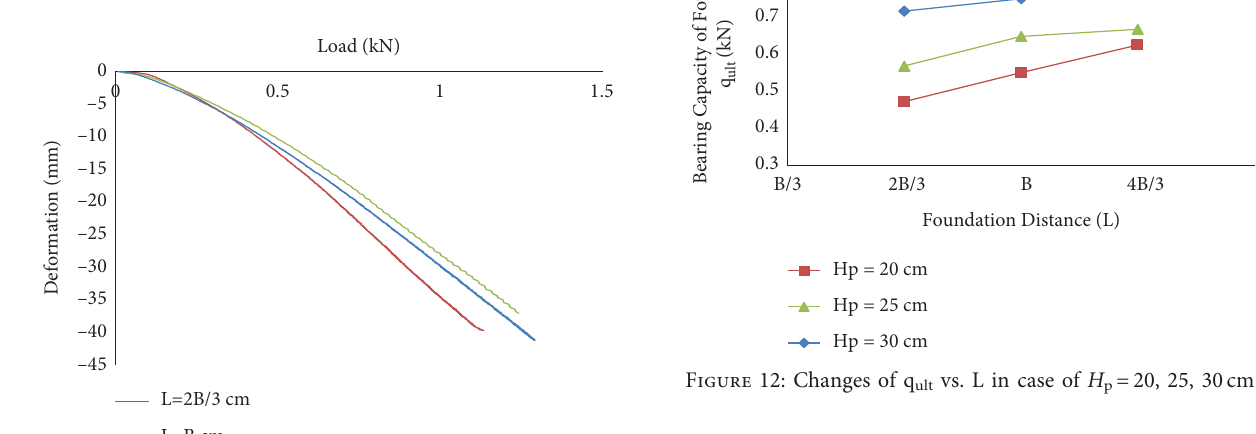
ult vs. L in case of H p